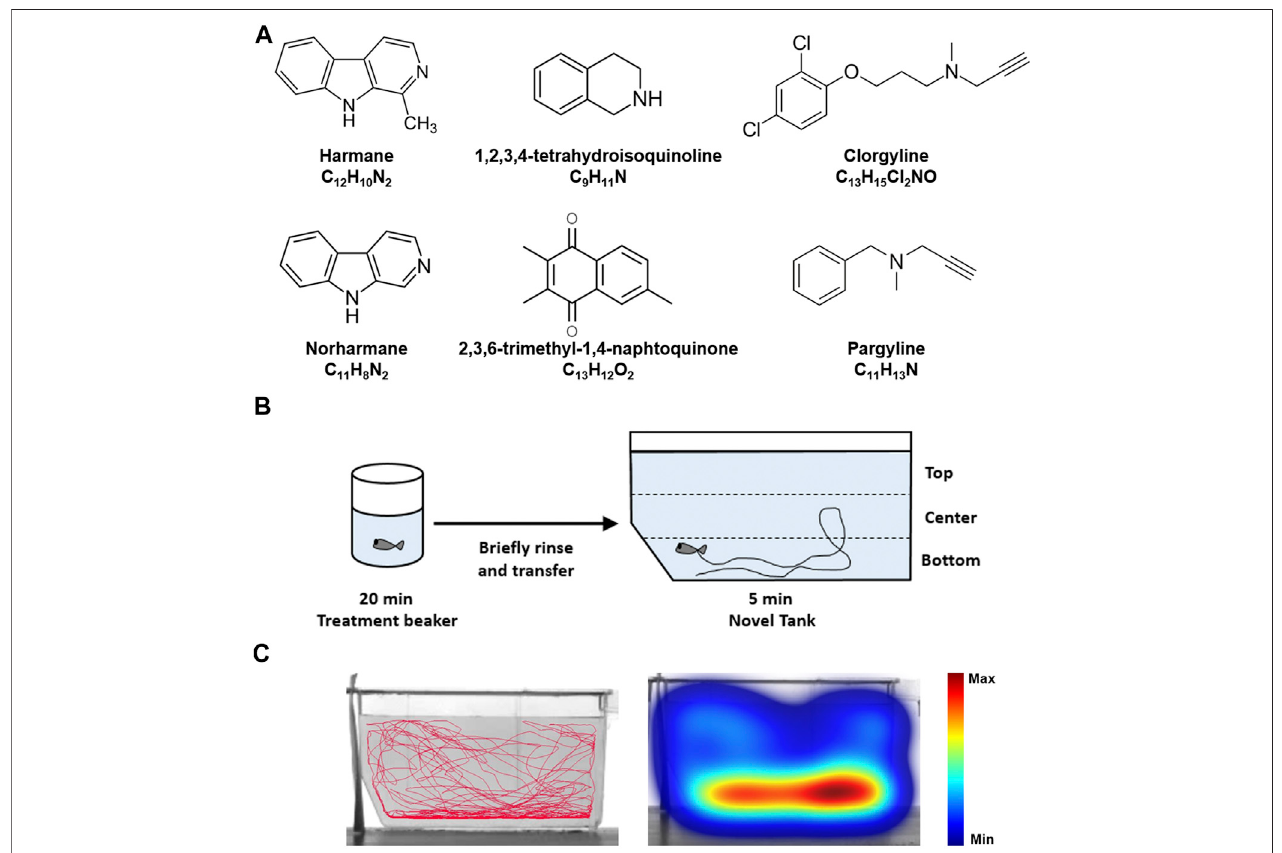
FIGURE 1 | Zebra fi sh NTT experimental paradigm (A) The chemical structures of the test compounds – harmane, norharmane, TMN, TIQ, clorgyline, and pargyline – are shown (B) Zebra fi sh are placed in a treatment beaker with respective compounds for 20 min, brie fl y rinsed in system water, and then monitored in a novel tank for 5 min. The time spent at the top and bottom one third of the tank were then analyzed (C) A representative trace and heatmap of the swimming activity is presentedforavehicle control.Theheatmapshowstheminimum(dark blue)tomaximum(darkred)amountoftimea fi shspentineach pixel.Abbreviations:NTT (cid:1) novel tank